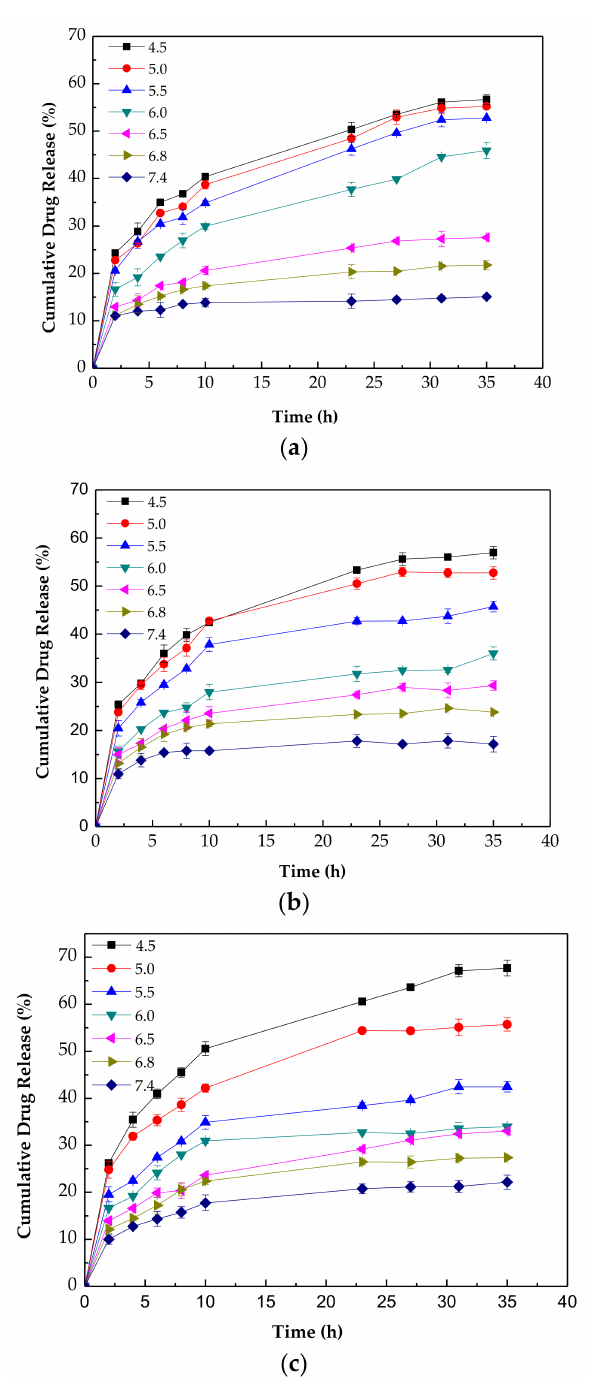
Figure 7. Drug release profiles of DOX from DOX-loaded Ad-(PC 22 - b -PD 18 - b -PP 8 ) 4 micelles ( a ), Ad-(PC 28 - b -PD 18 - b -PP 8 ) 4 micelles ( b ), Ad-(PC 28 - b -PD 25 - b -PP 8 ) 4 micelles ( c